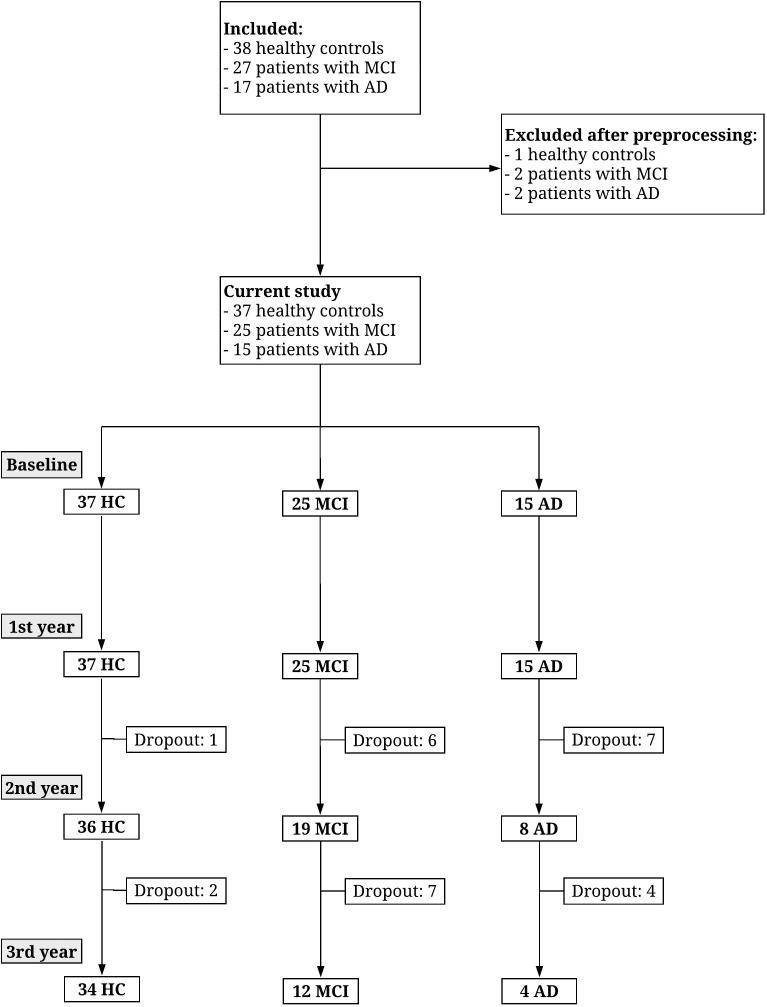
Flow diagram showing the number of participants recruited and drop-out over 3 years. Figure reproduced from Musaeus et al. (2018b).